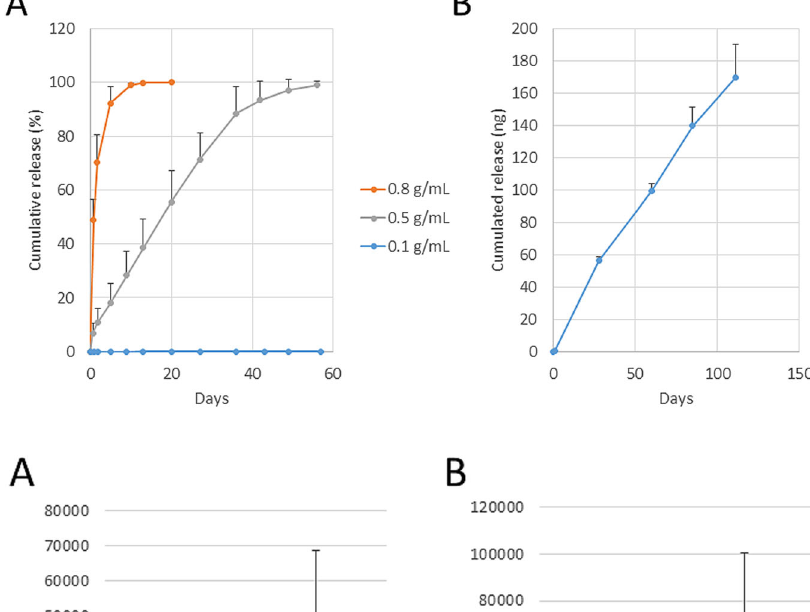
Fig. 4 Evaluation of the CNV area at ( A , B ) 8 and ( C , D ) 18 weeks after treatment with ( A , C ) ranibizumab-DDS and ( B , D ) monthly intravitreal injections of ranibizumab. Data are the mean ± SD; n = 16. * P < 0.05; ** P < 0.01 ( t -test). CNV choroidal neovascularization, DDS drug delivery system, iv intravitreal injection, PBS phosphate buffered saline, SD standard